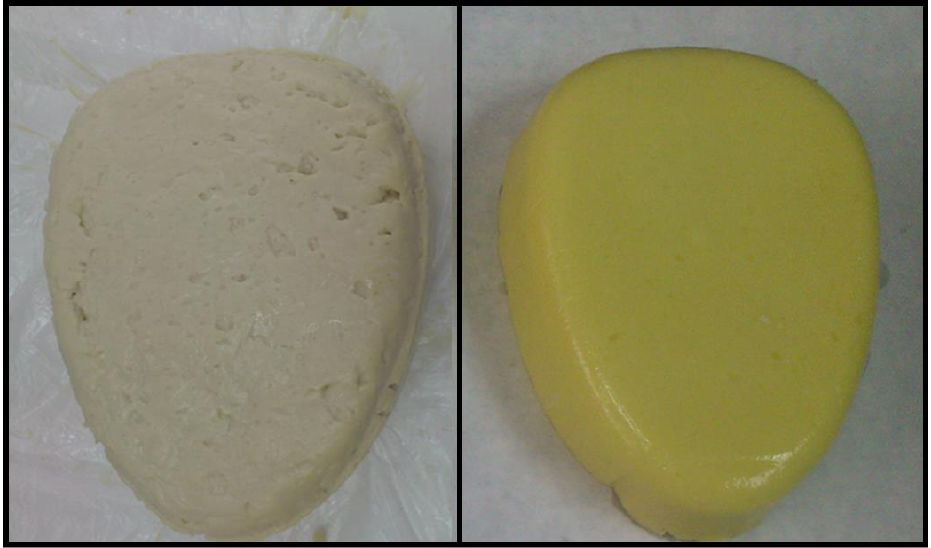
Figure 3. Representative appearance of oil-free SPI gel (SPI/G, left ) and SPI emulsion gel (SPI/EG, right ). For sample denomination see Table 1.